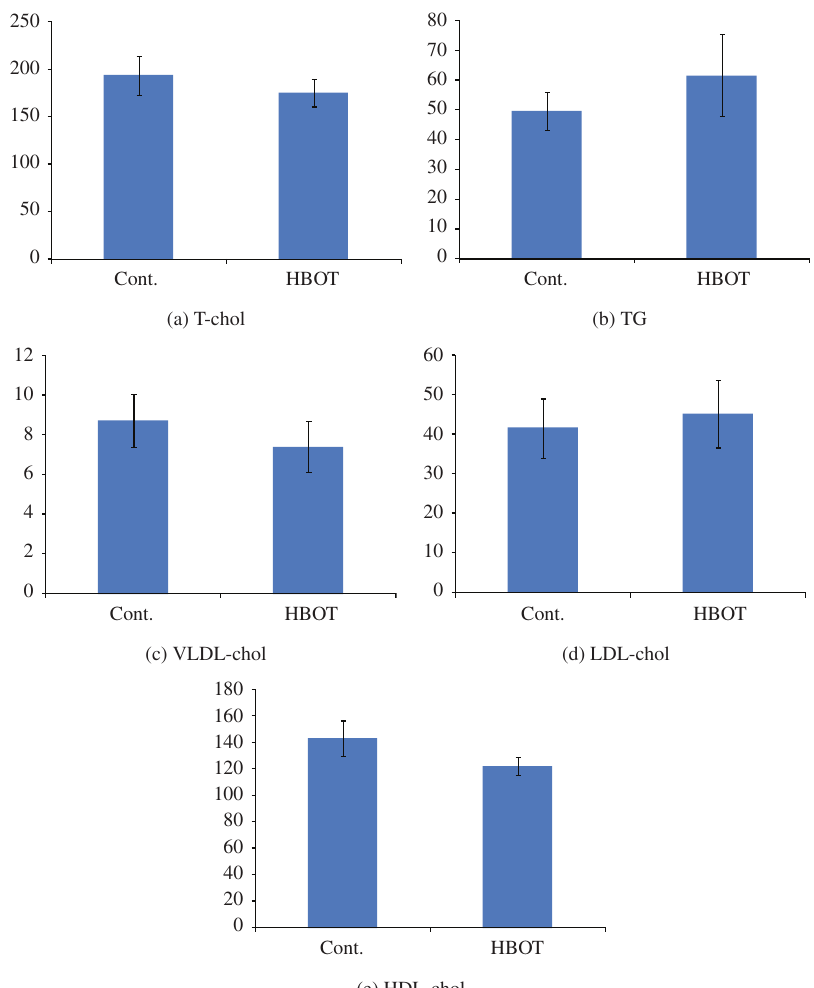
FIGURE 3: The serum lipid levels of each group (Student’s t